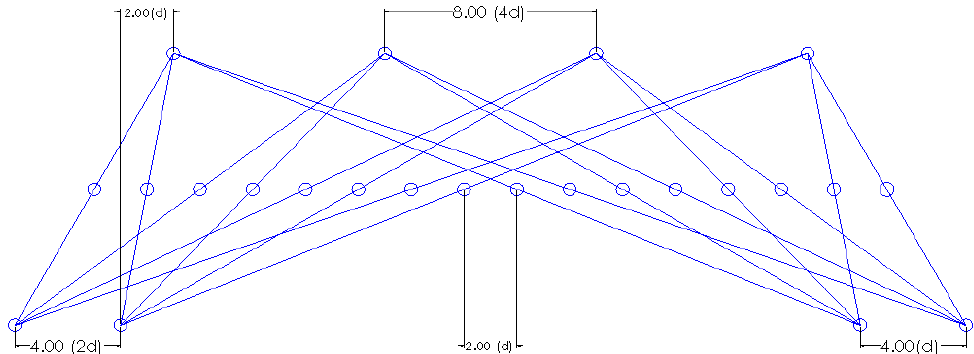
Figure 1. Virtual antenna array geometry, wherein the top row indicates transmit and the bottom row receive. The middle row is the evenly spaced linear virtual array creating a 4 × 4 array.